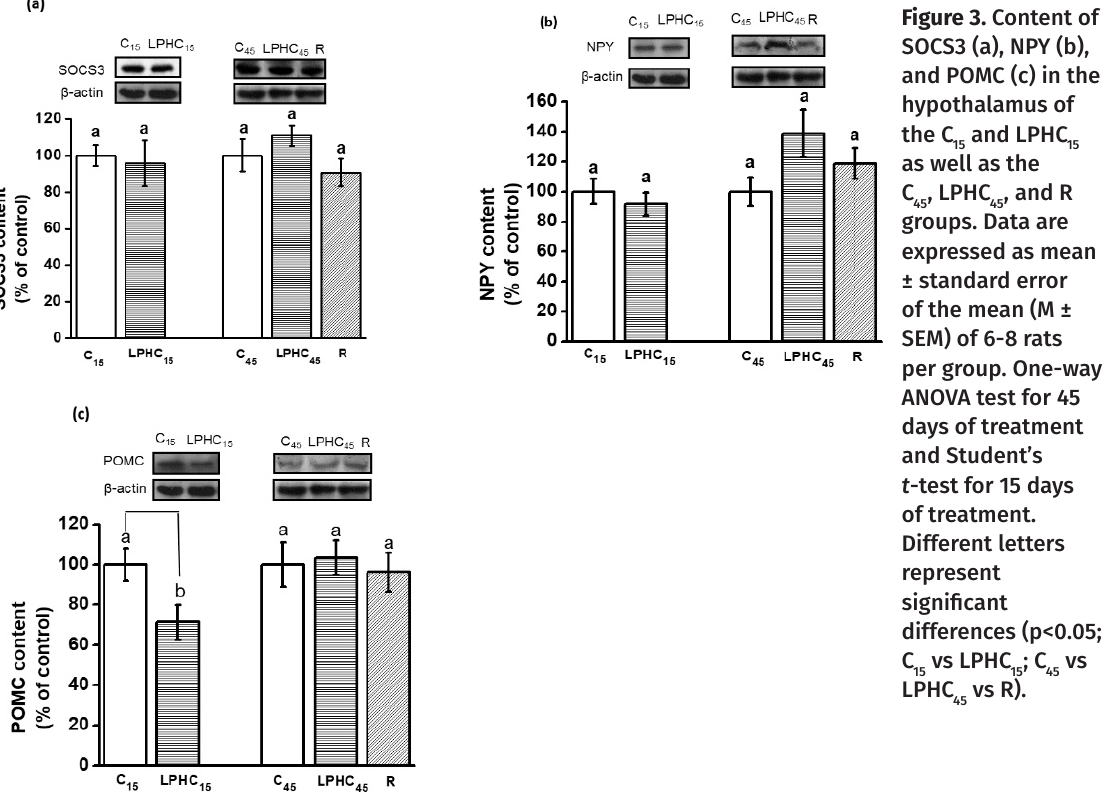
Figure 2. Content of the long form of the leptin receptor (ObRb), JAK2, p-JAK2/JAK2, STAT3, and p-STAT3/STAT3 in the hypothalamus of the C and LPHC groups (a) as well as the C 15 15 mean ± standard error of the mean (M ± SEM) of 6-8 rats per group. One-way ANOVA test for 45 days of treatment and Student’s t -test for 15 days of treatment. Different letters represent significant differences (p<0.05; C LPHC ; C vs LPHC vs R. 15 45 45